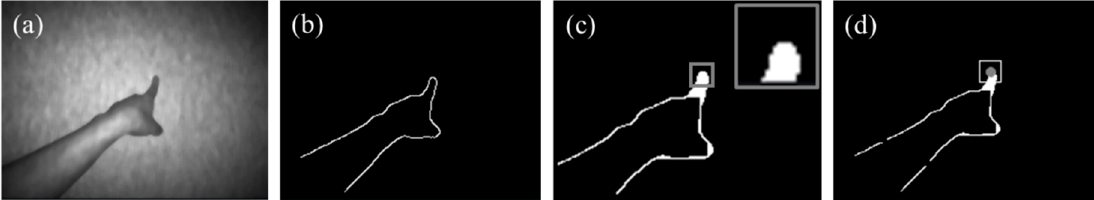
Figure 6. Touch detection method. It uses the IR image captured by the depth camera to extract the fingertip region.